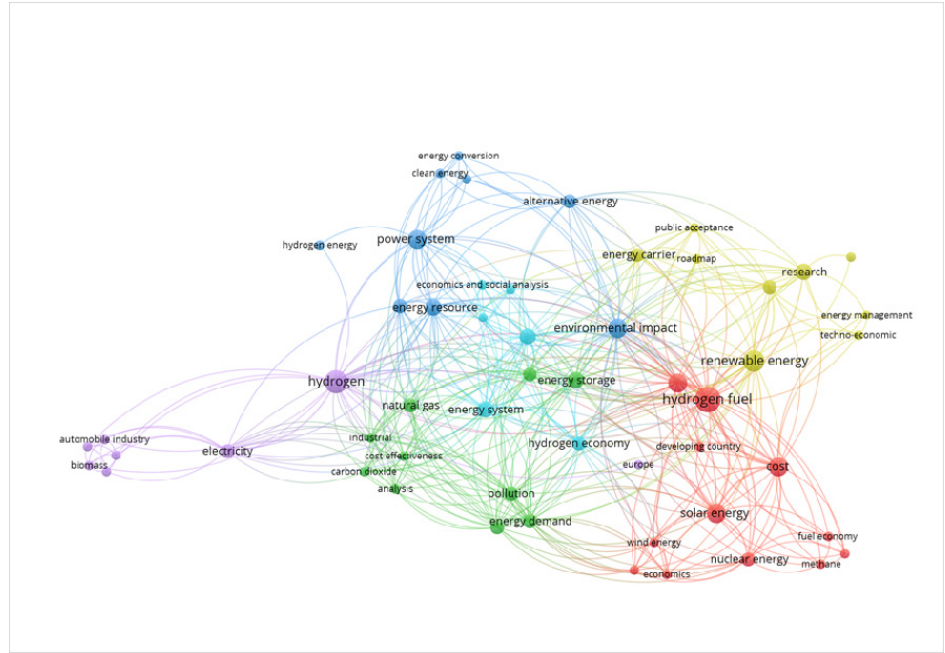
Figure 4. Keyword network map for 1990 to 1999.